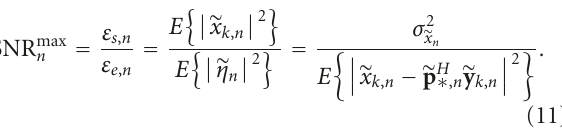
Figure 3: The bit rate performance of the BM-TEQ [11], adaptive RLM-based BM-TEQ (ABM-TEQ) [12], proposed MMSE-based BM-PTEQ, and proposed adaptive iQRRLM-based BM-PTEQ (ABM-PTEQ) for all CSA loop nos. 1–8 at starting tones 38 to 255 downstream ADSL when fixed Δ =